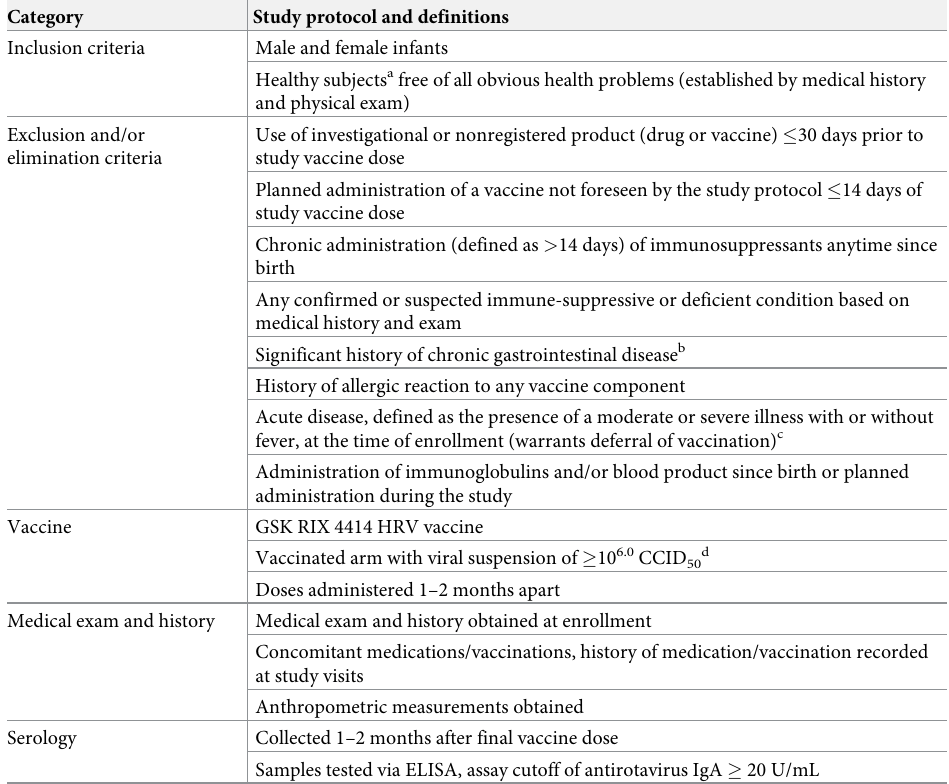
Table 2. Similarities across GSK trial protocols and